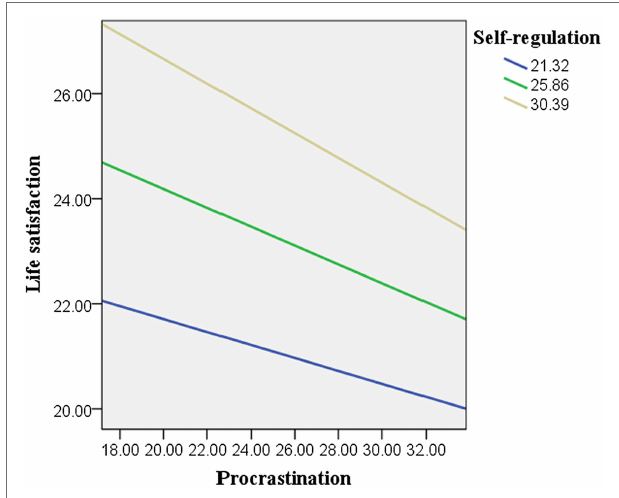
FIGURE 3 | Moderation effect of self-regulation in the United Kingdom.